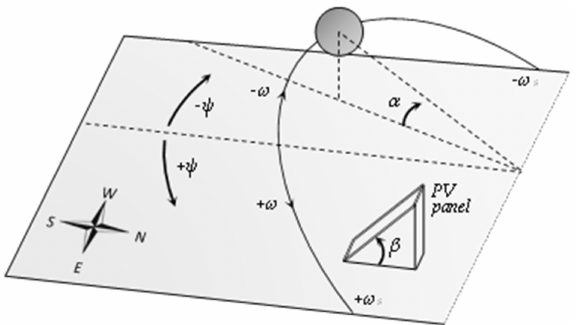
Figure 2. Sun angles (altitude angle α , azimuth angle ψ , and hour angle ω ) with respect to a static object on the